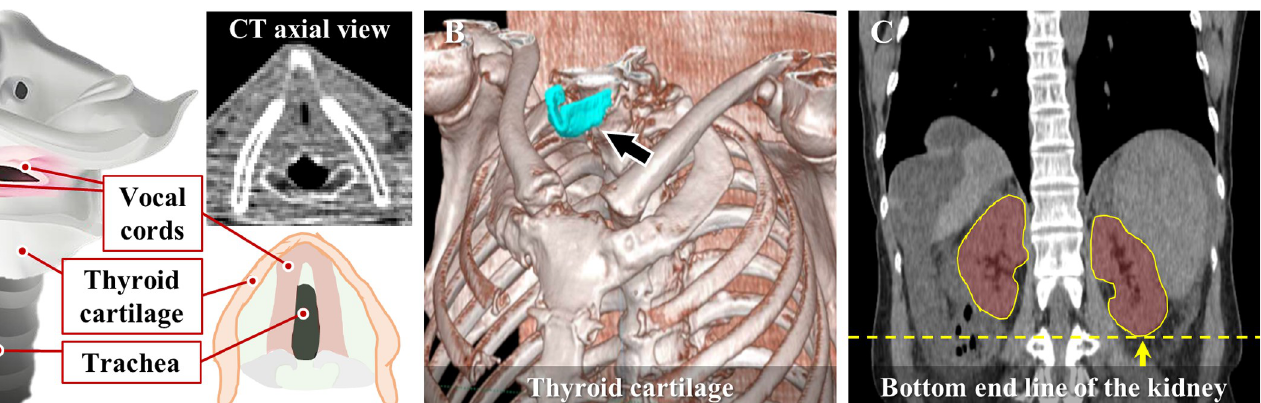
PLOS ONE | https://doi.org/10.1371/journal.pone.0275531 September 29,